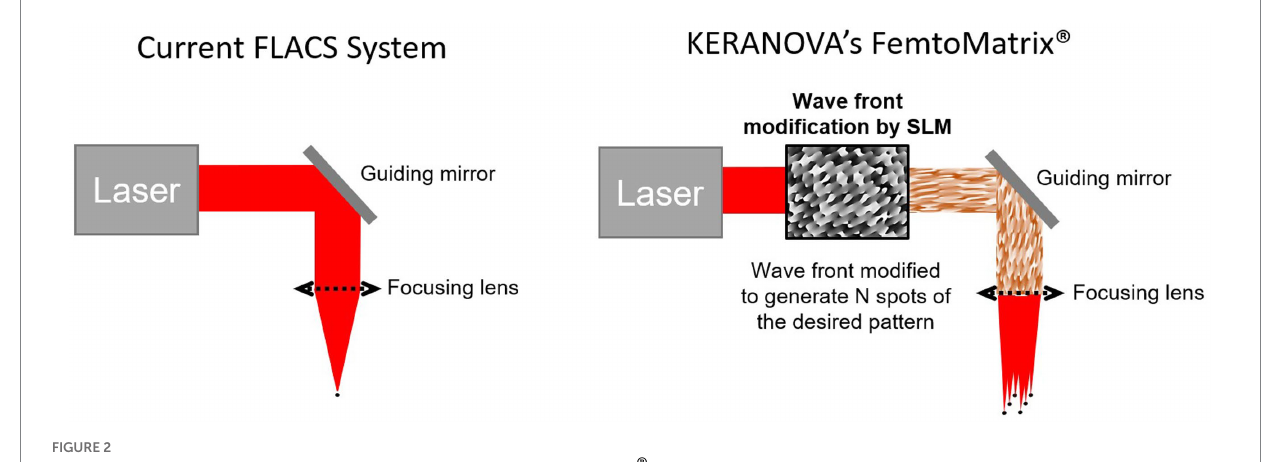
FIGURE 2 Comparison of laser spot generation for current FLACS versus FemtoMatrix ®